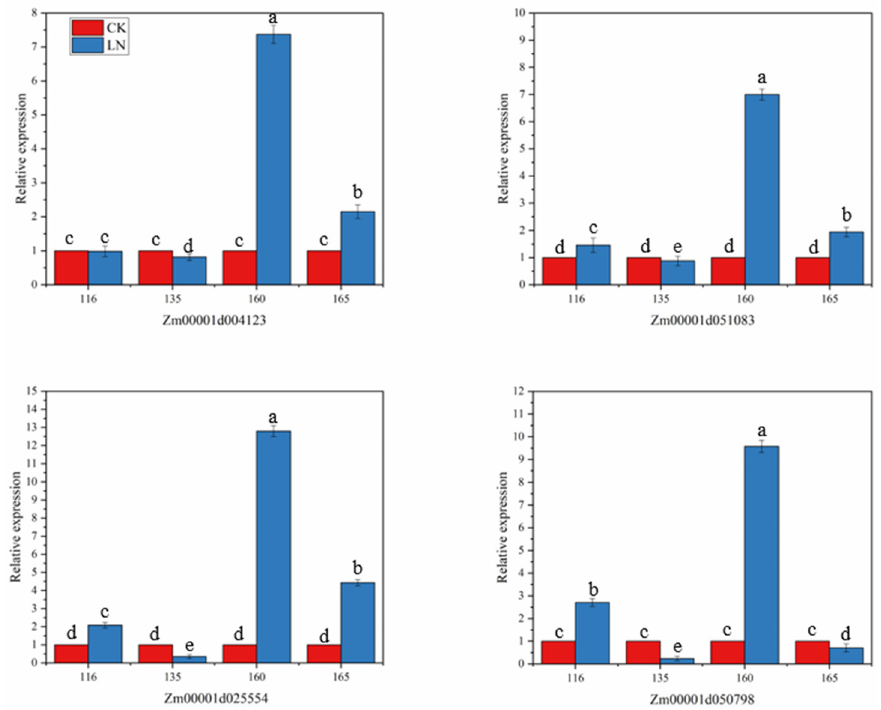
Figure 6. Expression analysis of four genes in roots of different sensitive lines of maize under nitrogen stress. In that order: The relative expression levels of genes Zm00001d004123 , Zm00001d051083 , Zm00001d025554 , Zm00001d050798 in roots of inbred lines 116, 135, 160 and 165 under low nitrogen stress. The inbred lines 116, 135, 160 and 165 represent four different haplotypes of inbred materials, of which 116 and 135 are unfavorable haplotypes, and 160 and 165 are favorable haplotypes. Error bars in the figure represent standard errors ( p < 0.05). Significant difference between groups in each nitrogen level is indicated by different letters ( p < 0.05).